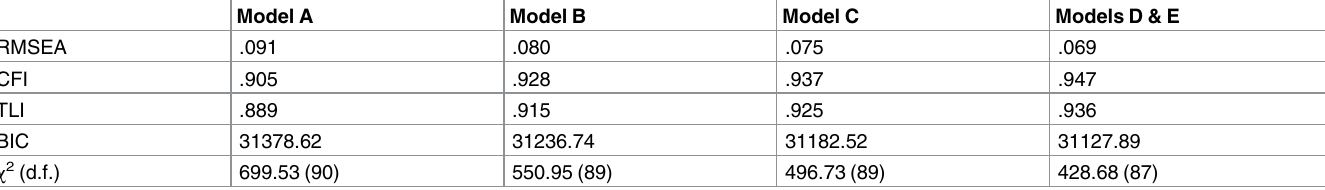
Table 3. Fit indices and comparisons between the four measurement models for police